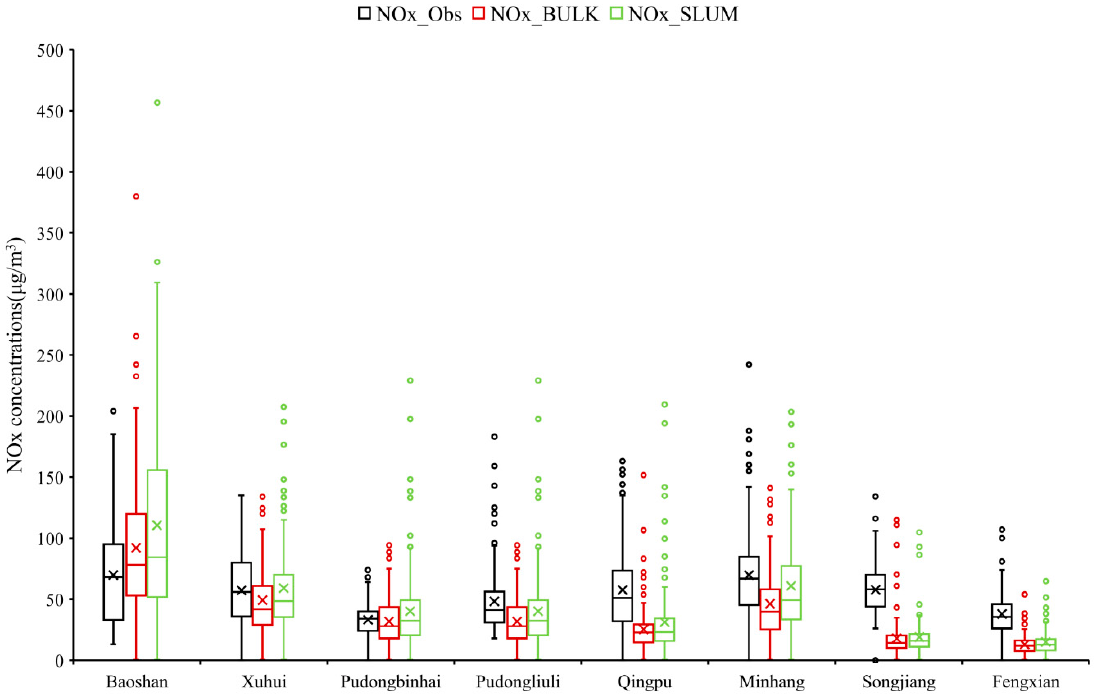
Atmosphere 2018 , 9 , x FOR PEER REVIEW Figure 10. Observed and simulated mean concentrations of eight stations on 1–8 July 2011.